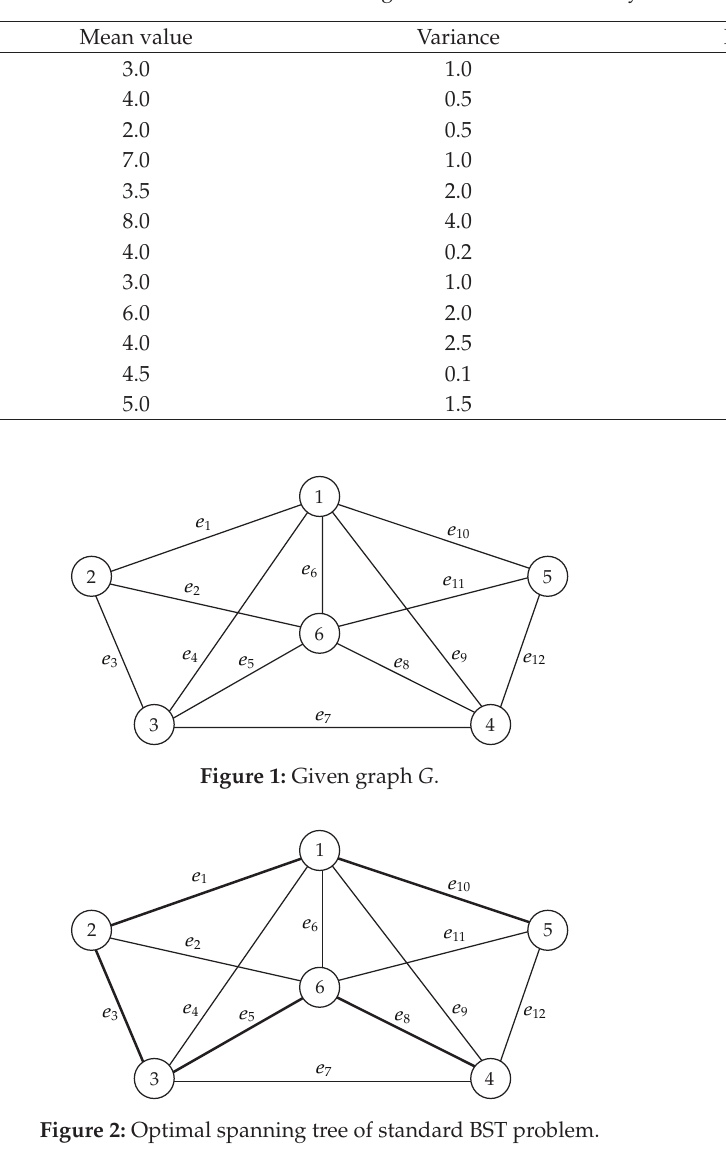
Table 1: Parameter values of random edge costs with the reliability.